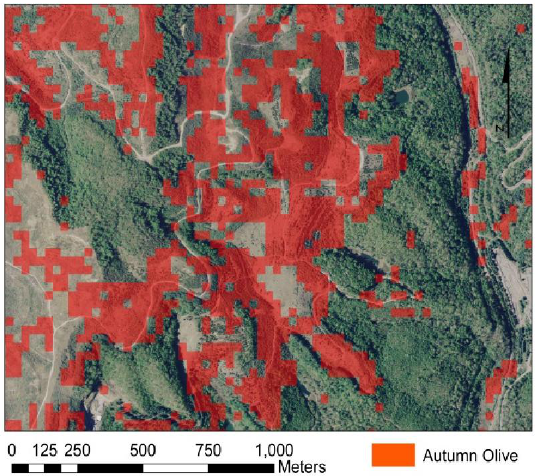
Figure 5. Classified areas of autumn olive in red are in good agreement with autumn olive on the landscape in the binary CART model.